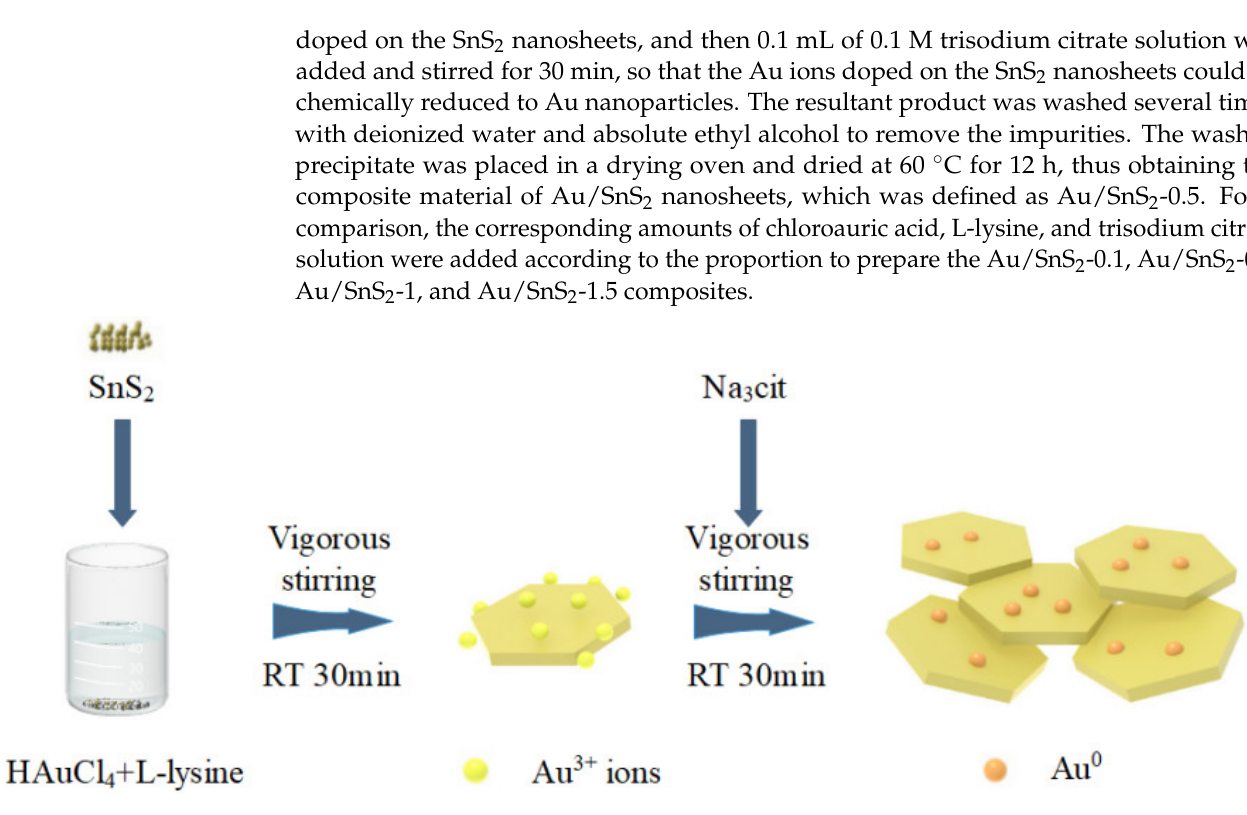
Figure 1. Schematic view of modifying Au nanoparticles on SnS 2 nanosheets.